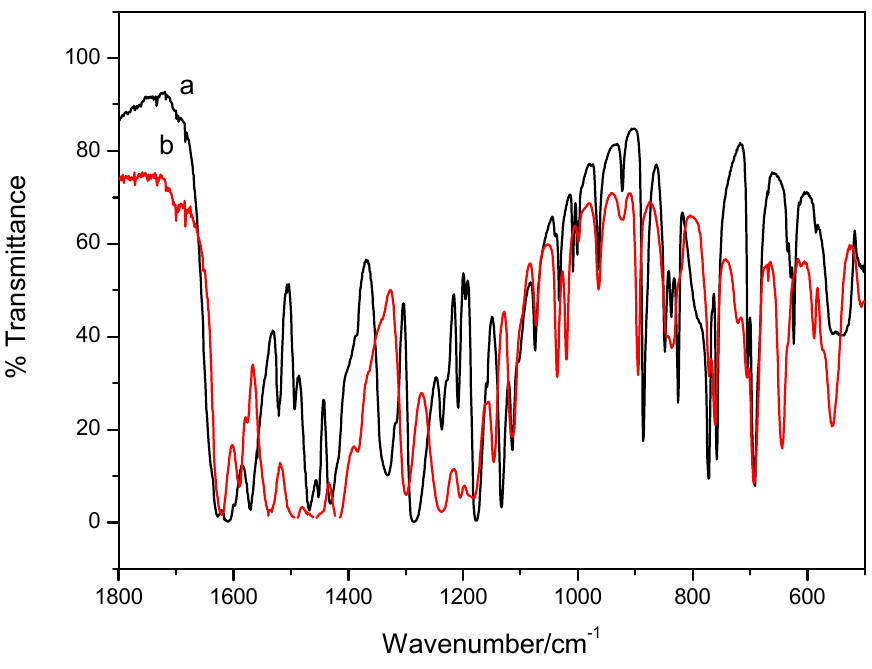
Figure 5. Infrared spectra of 3,7-dihydroxyflavone ( a ) and the complex [Cr(C 15 H 9 O 4 ) 3 ] ( b ). 3.1. Tris(3,7-dihydroxyflavonolate - κ O 3 ,O 4 ) chromium(III) Complex Synthesis Seventy-two milliliters of an ethanolic solution containing 0.41 g (1.5 mmol) of 3,7- dihydroxyflavone and 0.21 g (1.5 mmol) of sodium acetate were kept under stirring and reflux for one hour. To this solution, 0.13 g (0.5 mmol) of chromium(III) chloride (CrCl 3 ·6H 2 O), dissolved in ethanol were added dropwise and the reaction mixture maintained at room temperature for 24 h, when a precipitate appeared, which was filtered, washed with cold ethanol and dried in vacuo (yield: 39%). Elemental analysis: calcd for C 45 H 33 O 15 Cr ([Cr(C 15 H 9 O 4 ) 3 ]·3H 2 O): C, 62.4; H, 3.84. Found C, 60.6; H, 3.81.